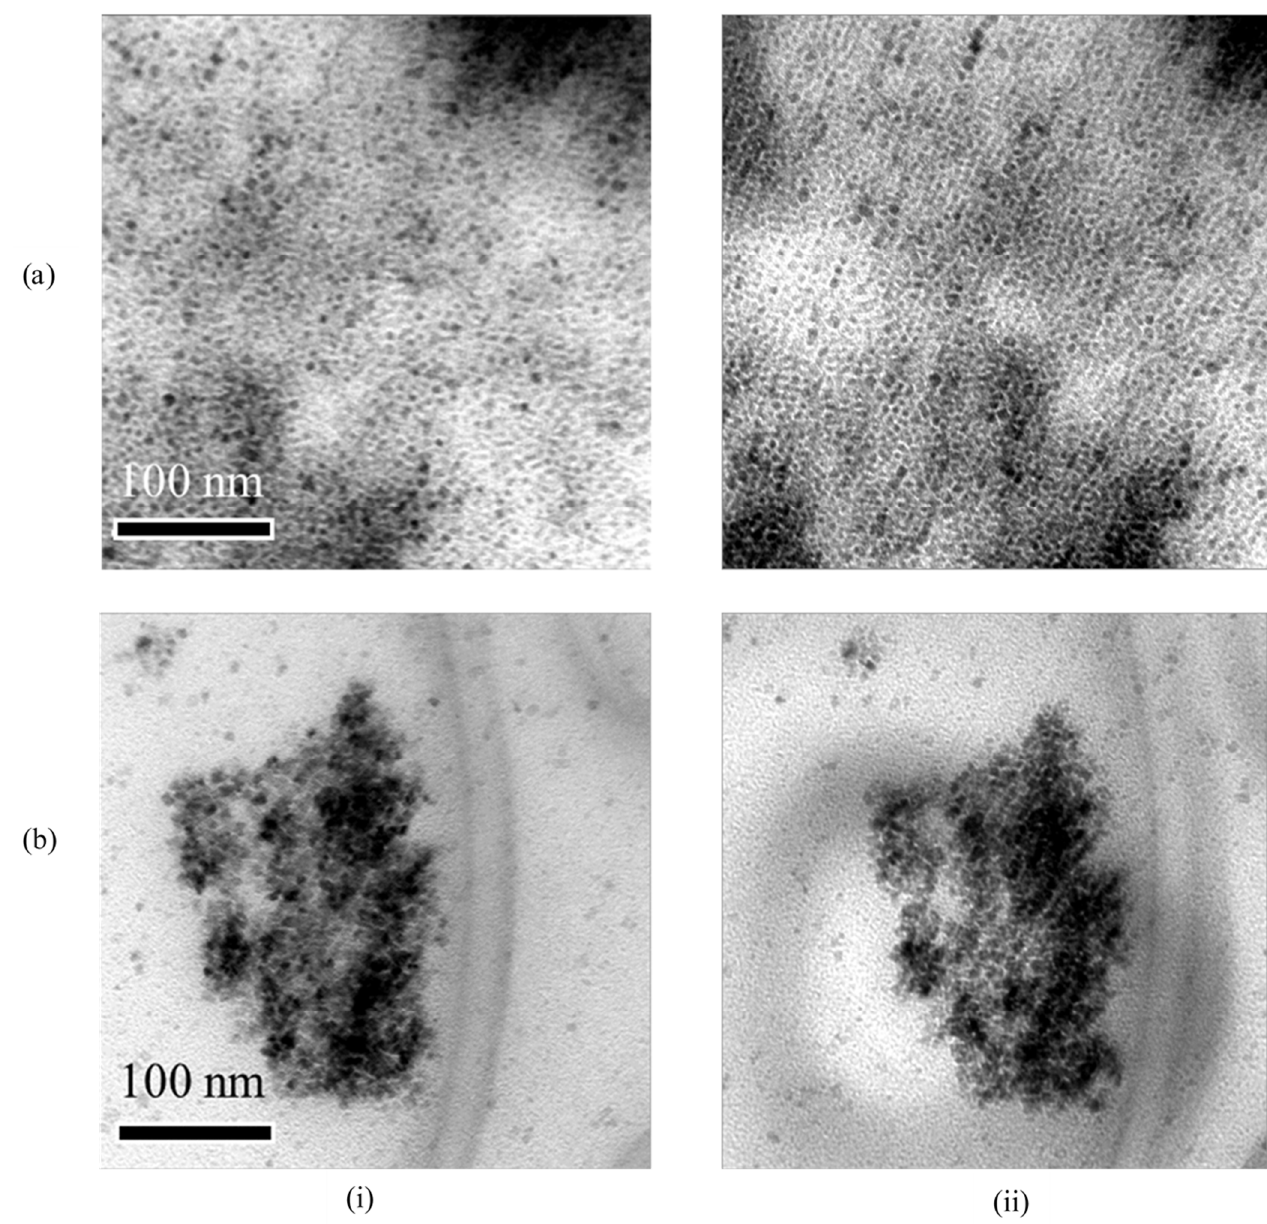
Figure 7. TEM images of nanoparticles generated from TBA preparation route during thermal annealing: ( i ) 25 °C and ( ii ) 500 °C where ( a ) CeO x (scale bar = 100 nm) and ( b ) Eu:CeO x (scale bar = 100 nm).